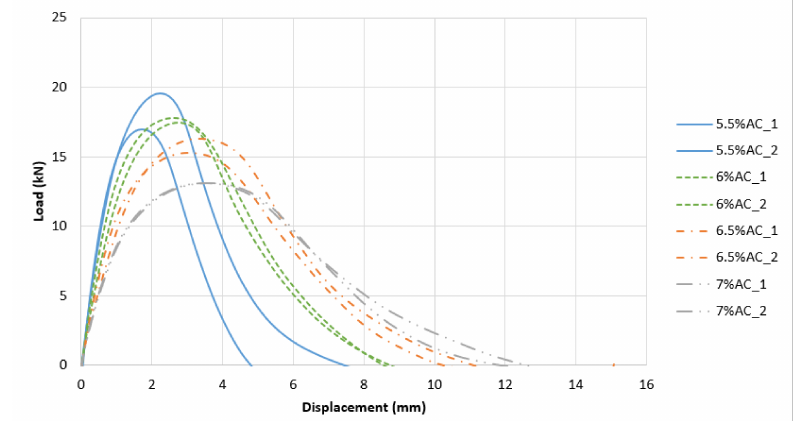
Figure 7. Load vs. Displacement Curves: 30-BMD.